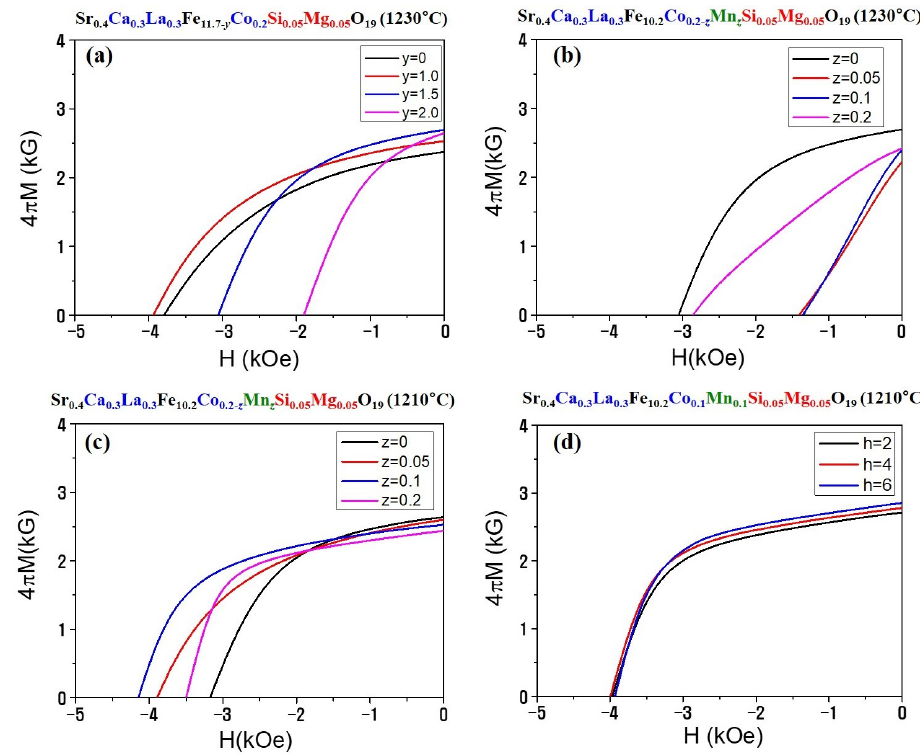
Figure 4. ( a – d ) Demagnetization curves (4 π M vs. H ) of the sintered Sr 0.4 Ca 0.3 La 0.3 Fe 11.7 − y Co 0.2 Si 0.05 Mg 0.05 O 19 ( y = 0, 1, 1.5, 2), and Sr 0.4 Ca 0.3 La 0.3 Fe 10.2 Co 0.2 − z Mn z Si 0.05 Mg 0.05 O 19 ( z = 0, 0.05, 0.1, 0.2) hexaferrites.